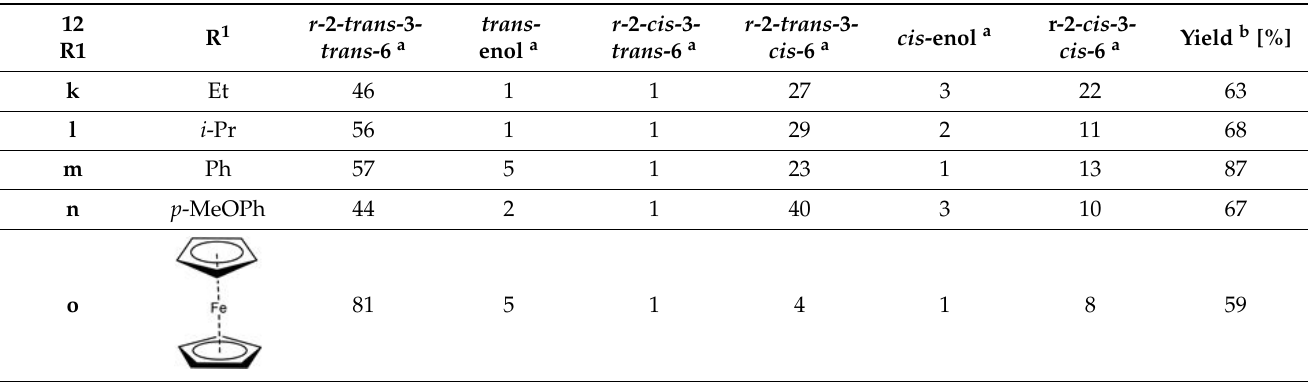
Table 3. Yields and ratios of isomers of 6-substituted 3-diethoxyphosphoryl-2- isopropyltetrahydropyran-4-ones 12k–o